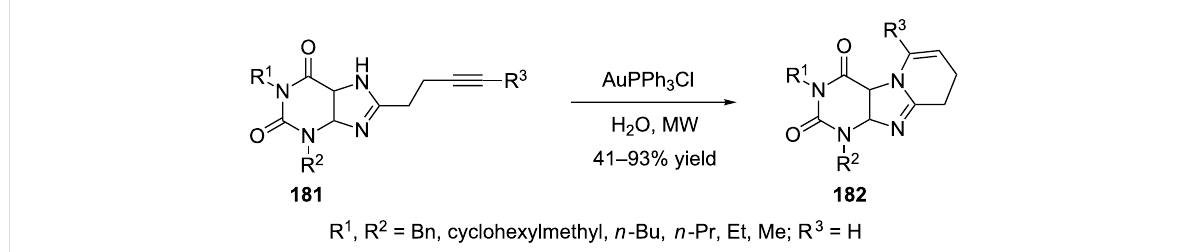
Scheme 33: Gold-catalyzed synthesis of fused